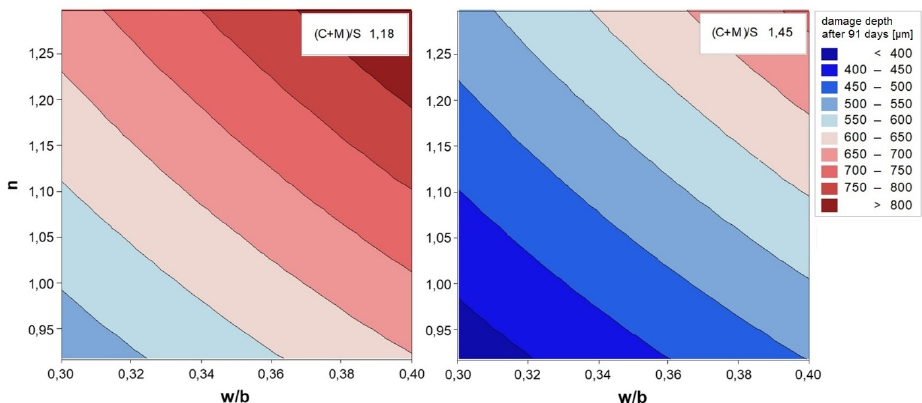
Figure 11. Influencing factors to the damage depth of the concrete specimen after 91 days of storage in sulfuric